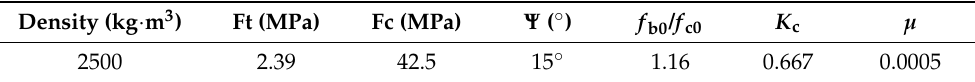
Table 8. Experimental data of the tensile strength of connections.